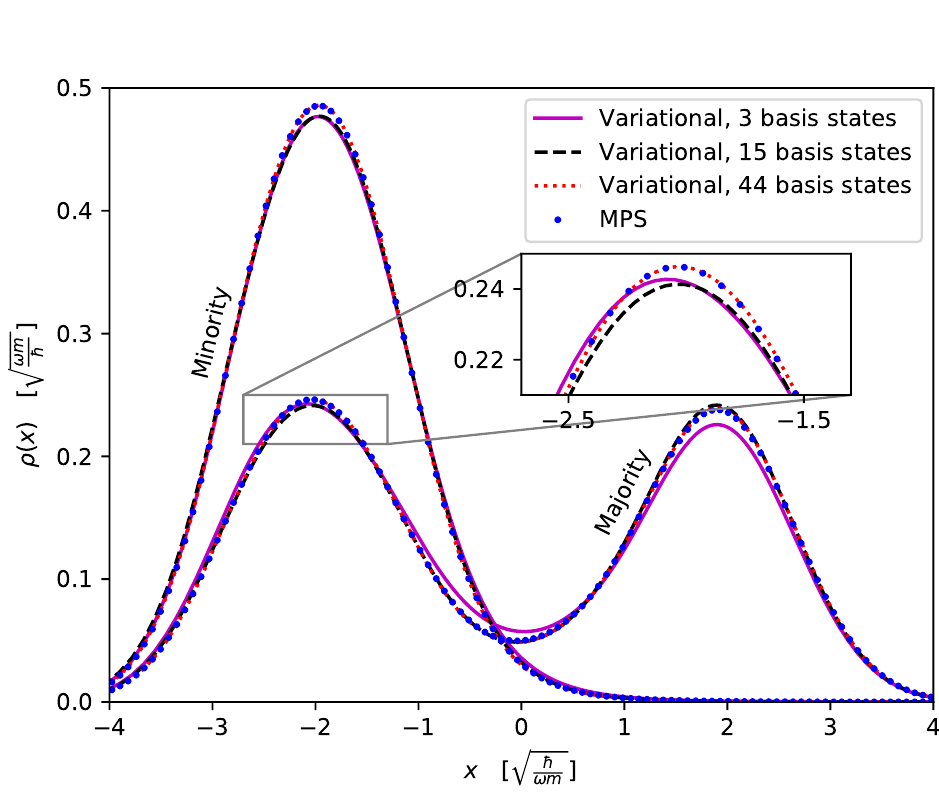
(cid:113) m = 1 for the 2 + 1 ħ h 3 ω